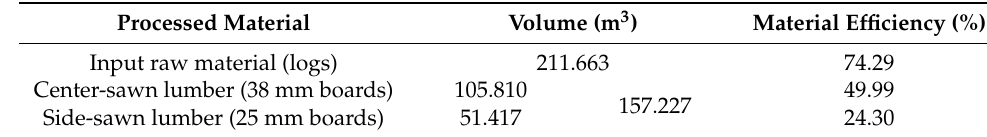
Table 4. The results of the wood sawing process in the “B” test.